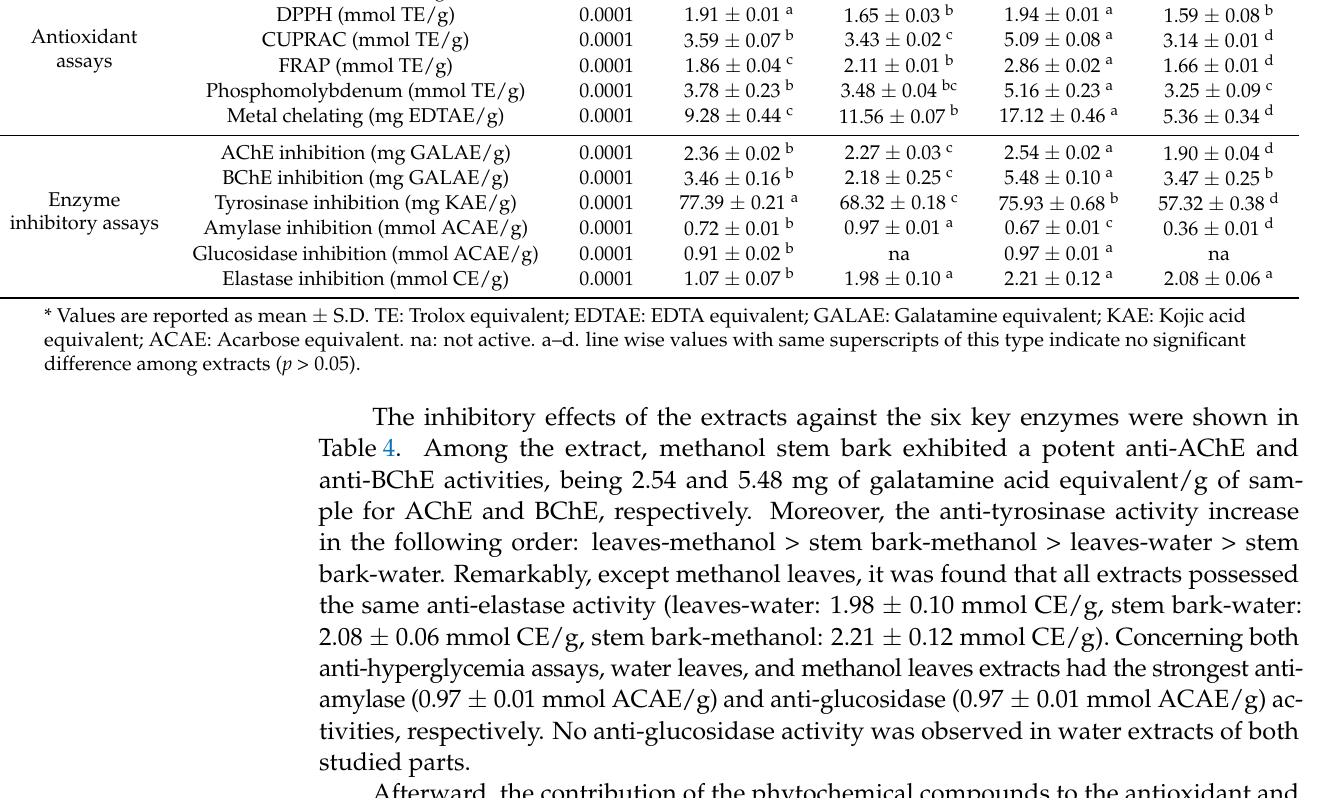
Leaves Stem Bark p -Value Leaves Water Methanol